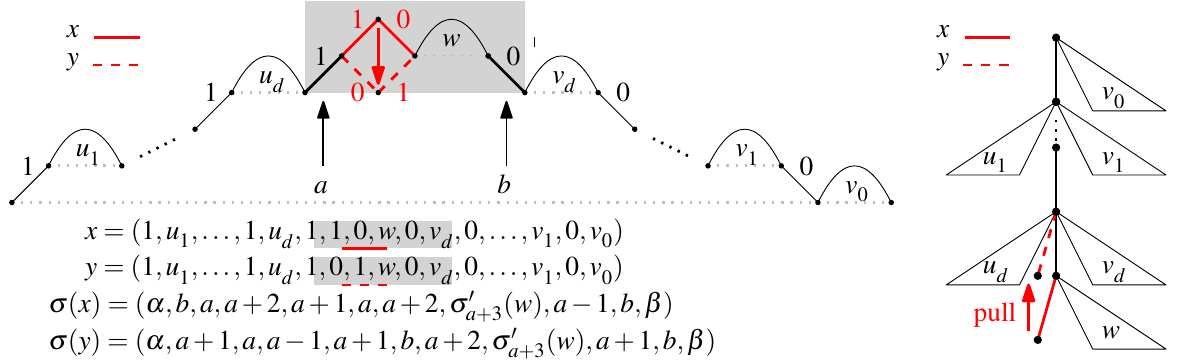
Figure 2: A flippable pair ( x , y ) , its Dyck path interpretation (left) and rooted tree interpretation